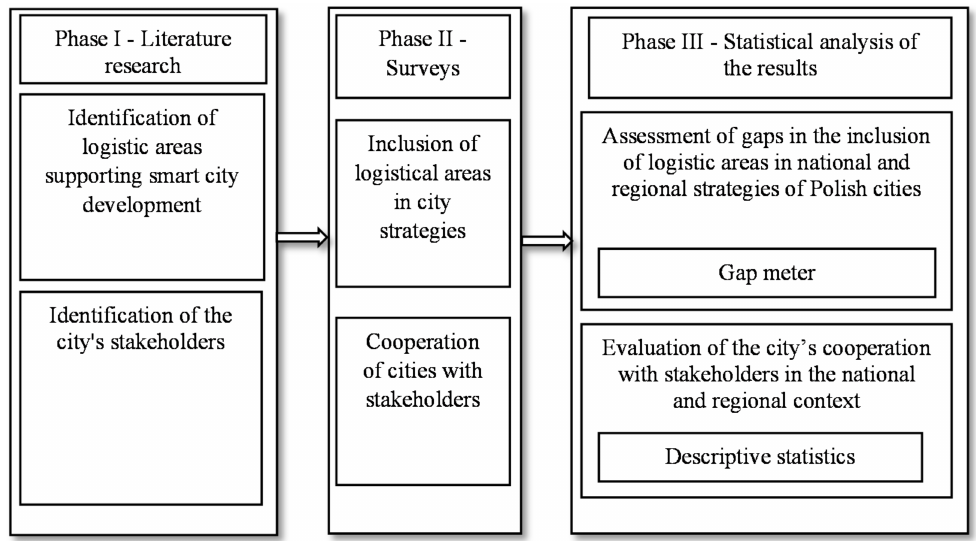
Figure 1. Research